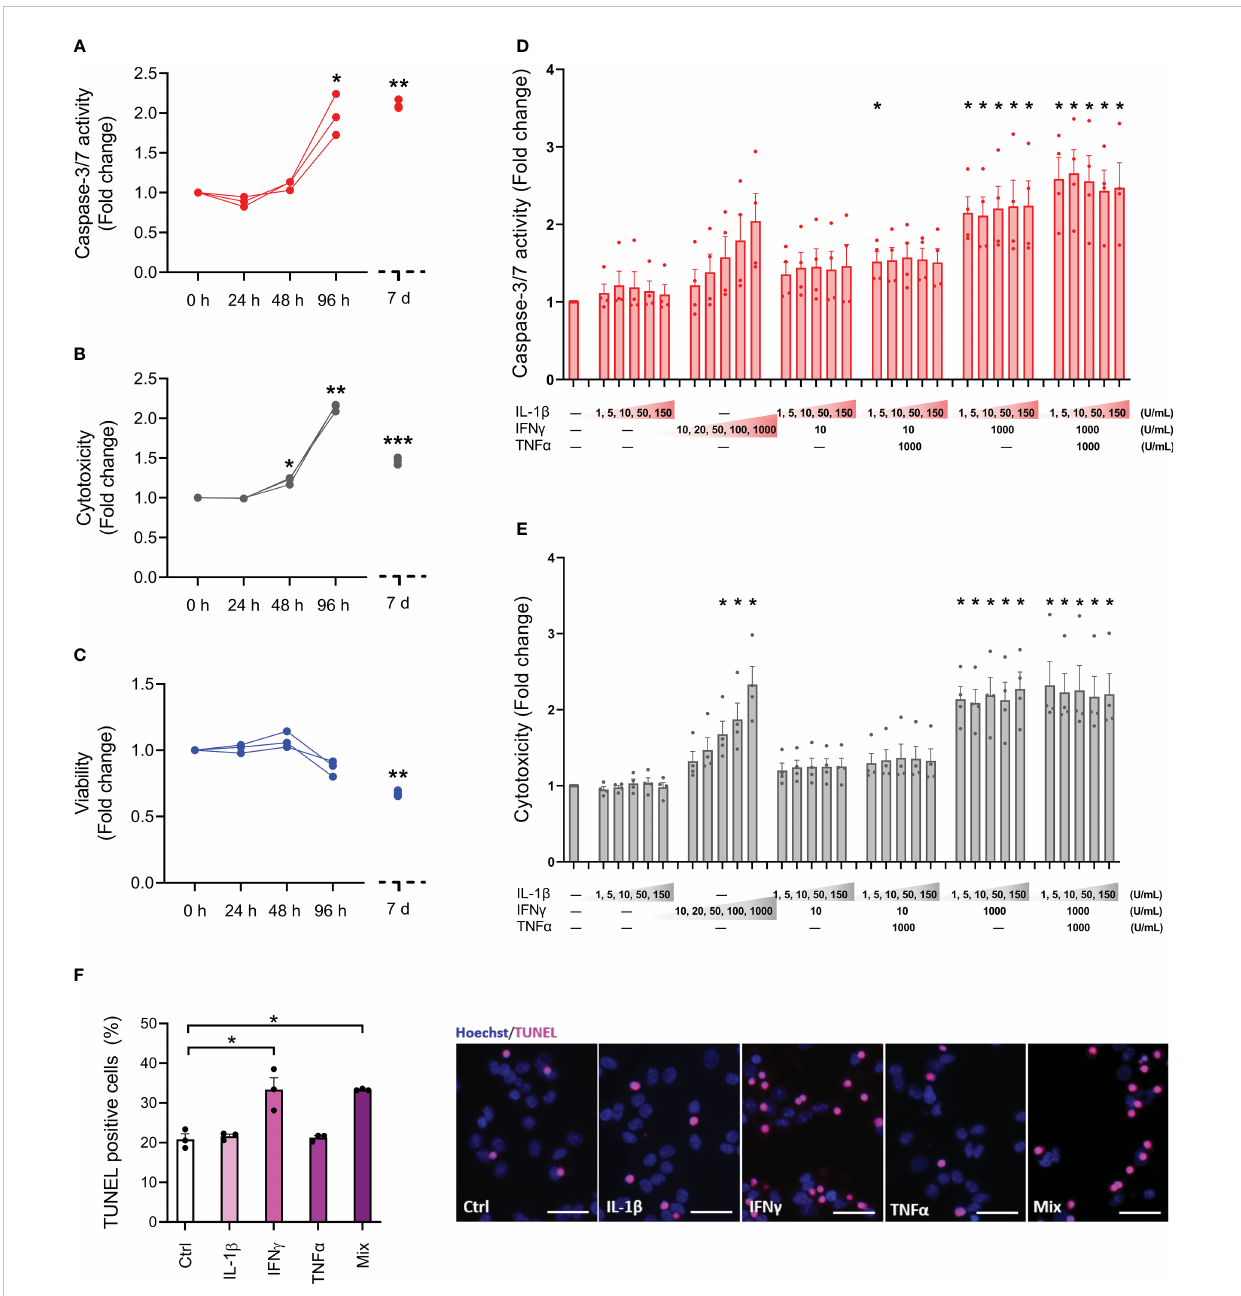
FIGURE 1 Cytokine sensitivity pro fi le of EndoC- b H5 cells. (A) Caspase 3/7 activity, (B) cytotoxicity and (C) viability after exposure to cytokines (50 U/mL of IL- 1 b , 1000 U/mL IFN g and 1000 U/mL TNF a ) for 0 h, 24 h, 48 h, 96 h and 7 days. Data are means ± SEM (n=3), *p<0.05; **p<0.01. (D) Caspase-3/7 activity and (E) cytotoxicity after exposure to IL-1 b , IFN g and TNF a at the indicated concentrations for 96 h. Data are means ± SEM (n=4). Adjusted p-values *p<0.05. (F) TUNEL assay of EndoC- b H5 cells after exposure to cytokines (50 U/mL IL-1 b , 1000 U/mL IFN g and 1000 U/mL TNF a ) alone or in combination (Mix) for 96 h. Representative immuno fl uorescent images of TUNEL (pink) and nuclei staining with Hoechst 33342 (blue). Scalebar 50 m m (x20). Data are presented as % TUNEL positive to total nuclei count, with means ± SEM (n=3), *p<0.05. Ctrl, untreated